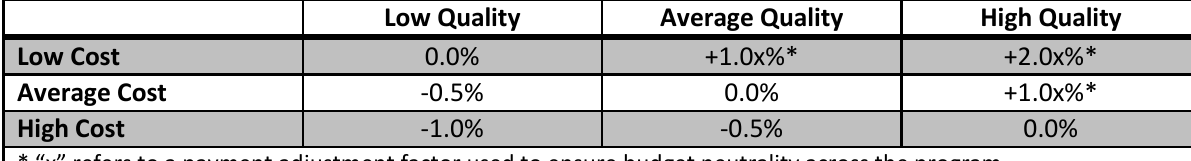
Table 10.1. Value Modifier, 2015 Payment Adjustment